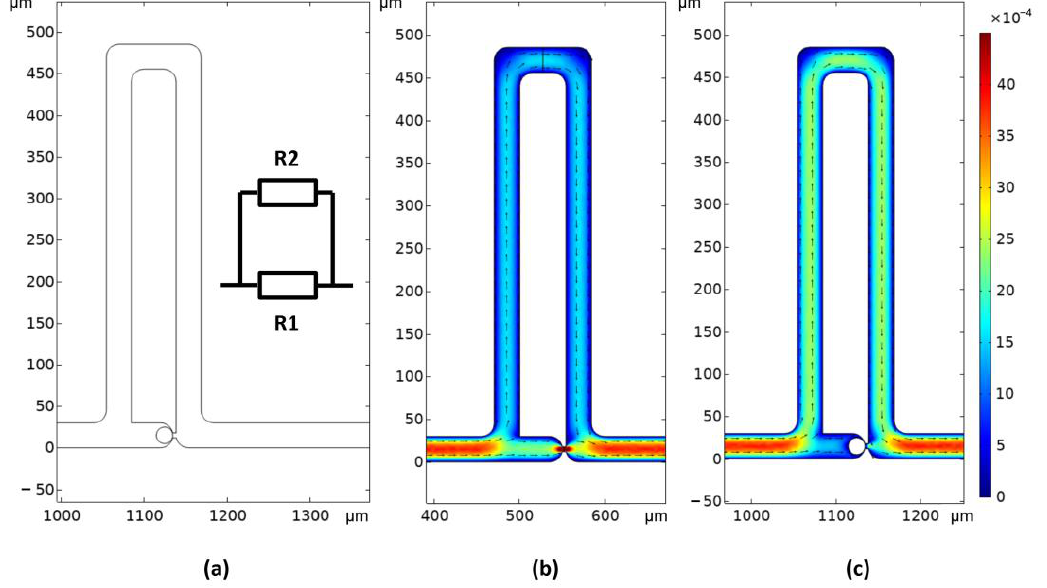
Figure 8. ( a ) Schematic of the microfluidic channel model and an associated diagram showing hydro- dynamic resistances R1 (narrow channel and trapping area) and R2 (bypass channel). ( b , c ) Cutaway views of fluid velocity (in m/s) in a channel ( b ) before and ( c ) after cell trapping. Note that R1 > R2 in ( b ) and R1 < R2 in ( c ).